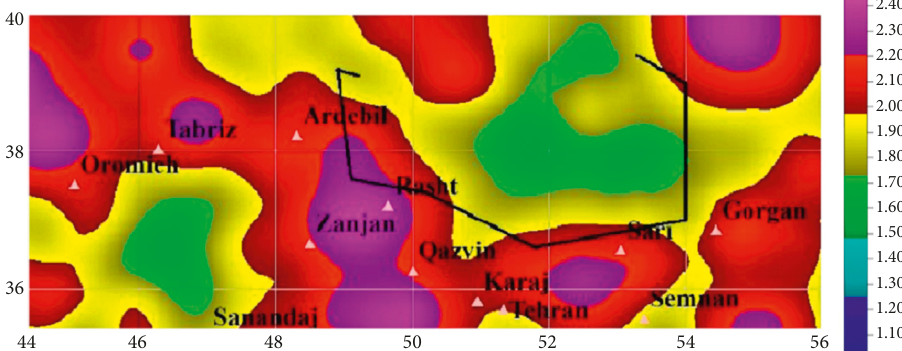
Figure 5: Map of 90% quintile of distribution of maximum values of log ( A